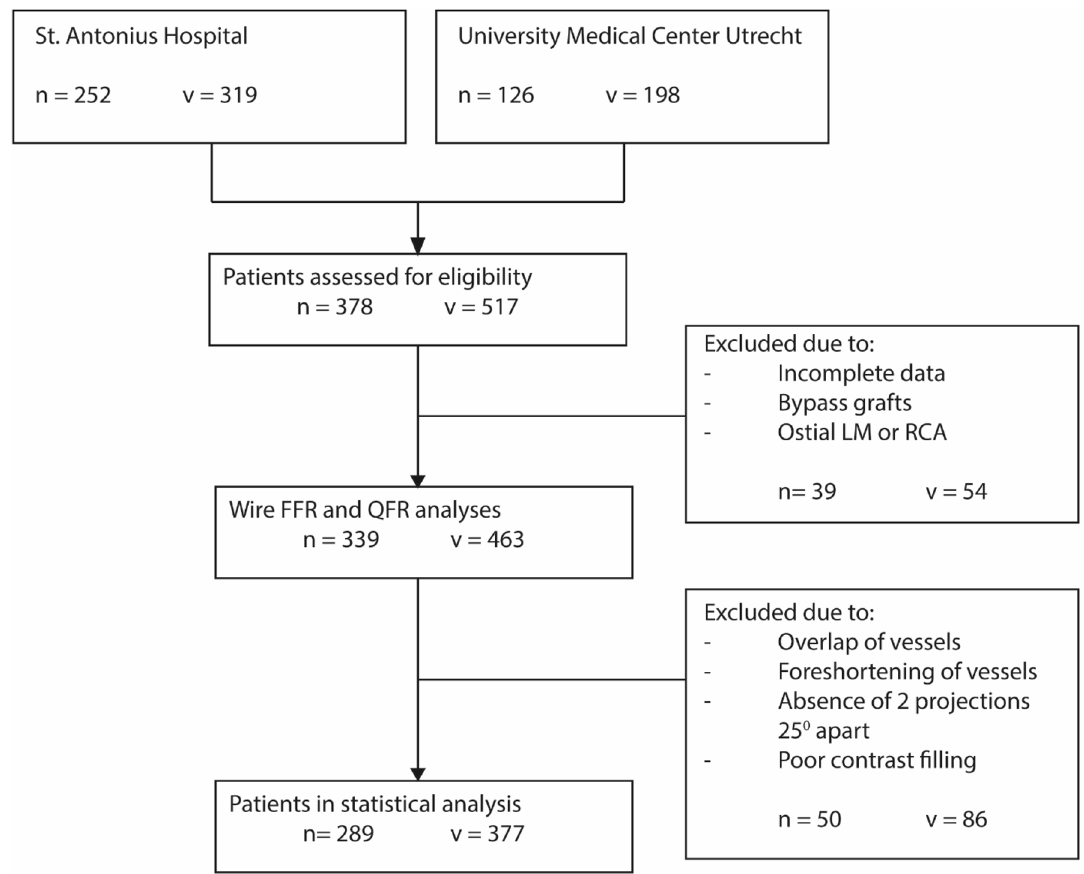
Figure 2. Study enrolment flow chart. FFR fractional flow reserve, LM left main coronary artery, N number of patients, QFR quantitative flow ratio, RCA right coronary artery, V number of